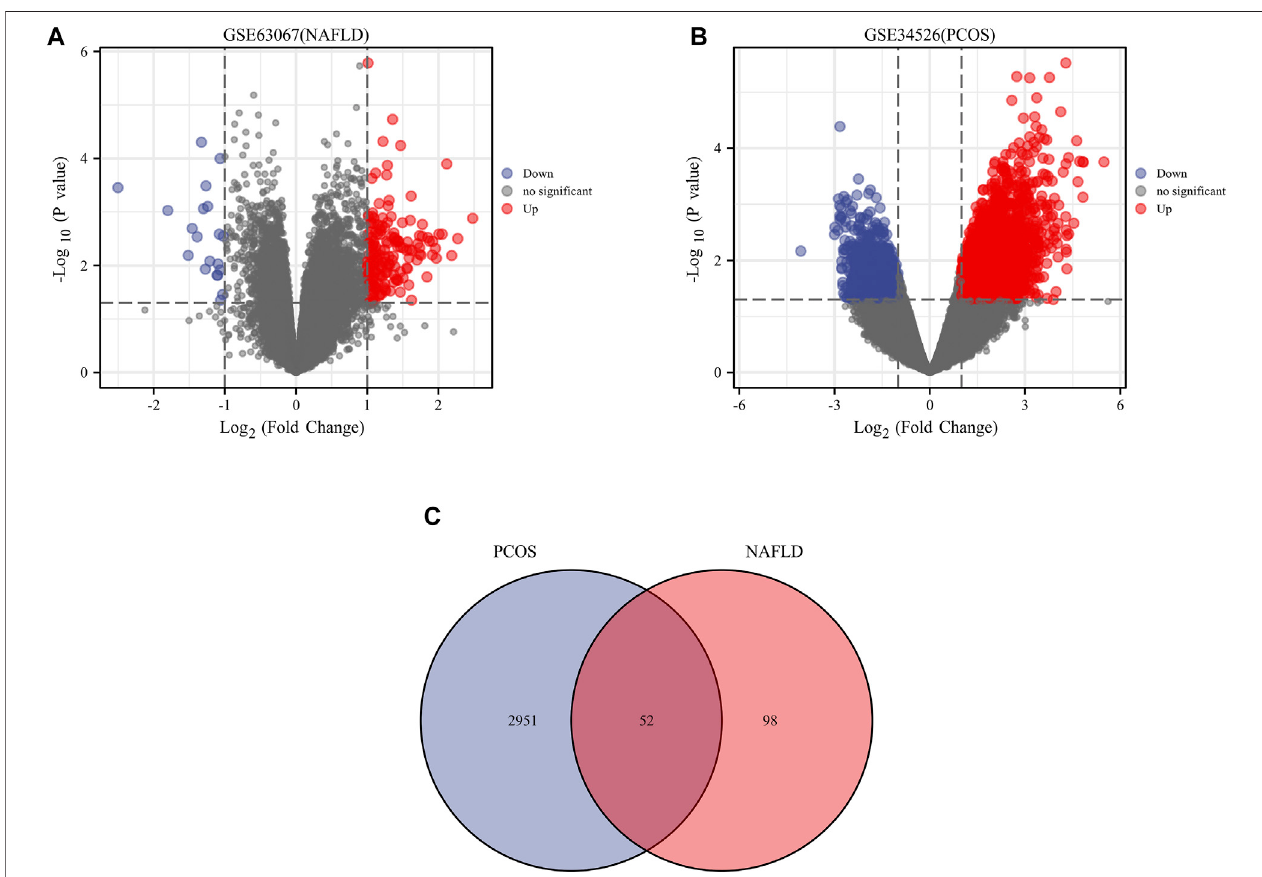
FIGURE 1 | The volcano plot and venn diagram of differentially expressed genes (DEGs). Panel (A) , volcano plot of DEGs in GSE34526; Panel (B) , volcano plot of DEGs in GSE63067; Panel (C) , venn diagram of DEGs in GSE34526 and GSE63067 gene chips. There are also two vertical dashed lines in the fi gure, representing log2FC at − 1 and 1; The horizontal dashed line represents adjusted p value at 0.05. Abbreviations: DEGs, differentially expressed genes; PCOS, Polycystic ovary syndrome; NAFLD, non-alcoholic fatty